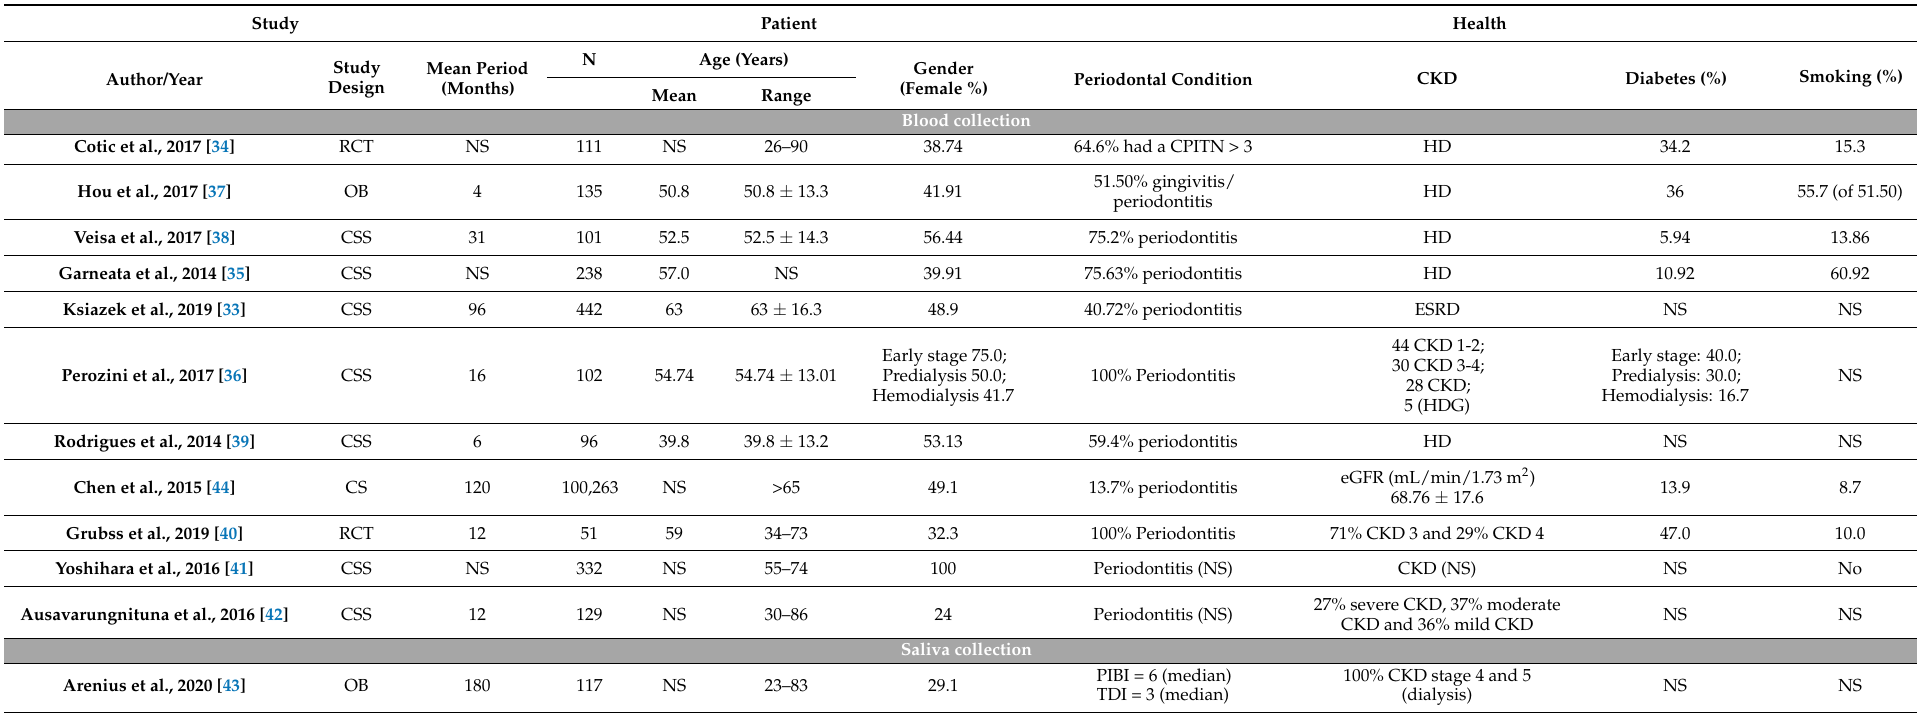
Table 4. Description of the factors investigated in the included